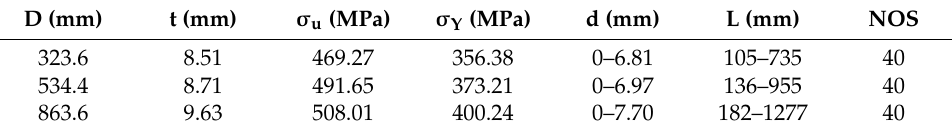
Table 4. Summary of pipeline geometry used for the prediction of burst pressure using FEM. D